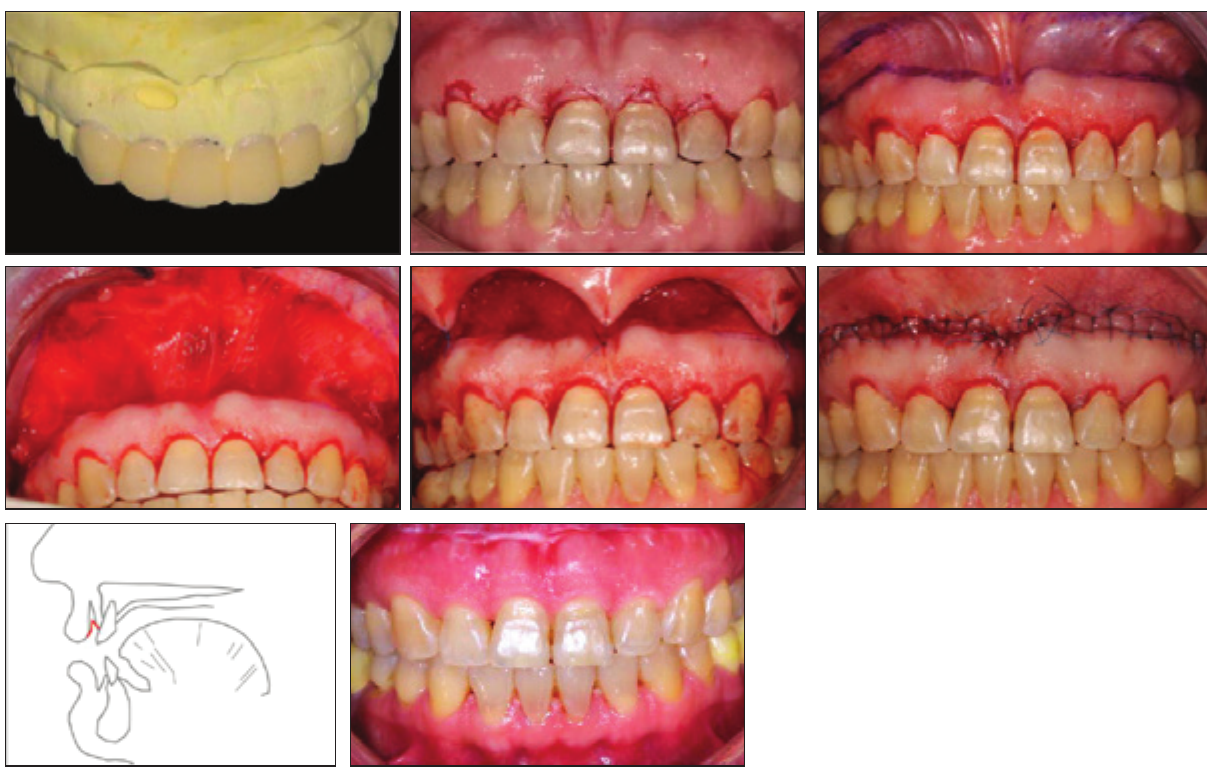
Figure 7. After orthodontic treatment, a mock-up was used for esthetic zone re-confirmation. Gingivoplasty and lip repositioning procedures were performed. The purpose of lip repositioning is to limit the labial retraction of the elevator smile muscles to reduce gingival display by means of shortening the vestibular